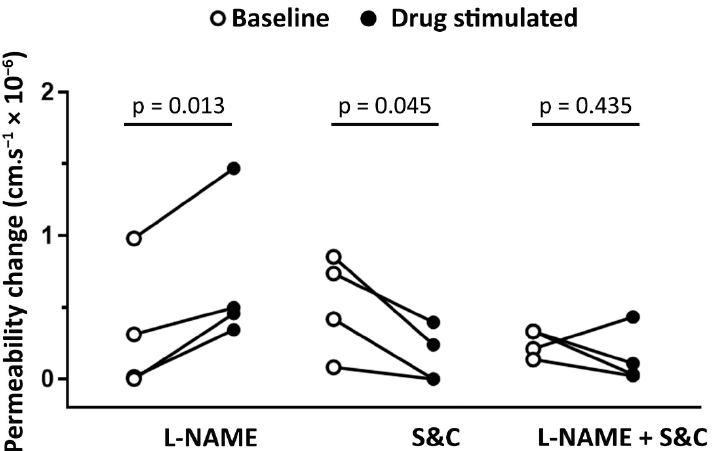
Figure 2. Constitutive nitric oxide reduces basal post-capillary venule permeability.